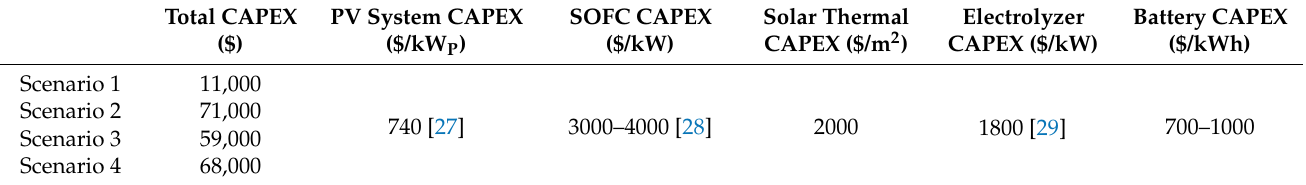
Table 11. The expected CAPEX of the HPS at each scenario in this study, in addition to the costs per each equipment. Abbreviations: Capital Expenditures